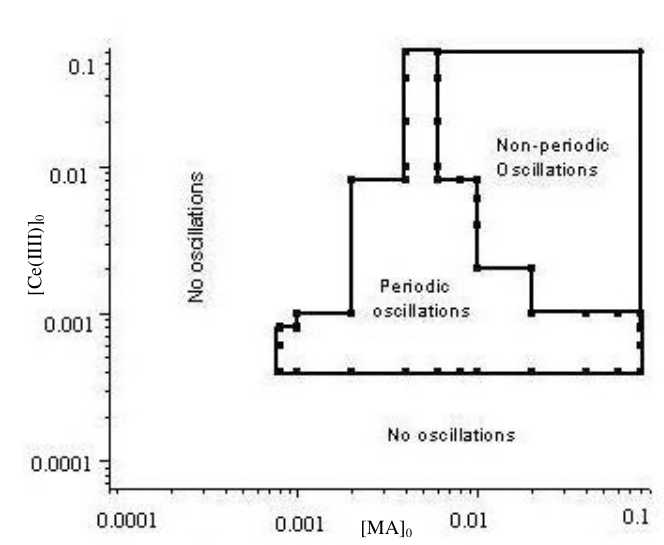
Figure 5 . Bifurcation phase diagram of [MA]